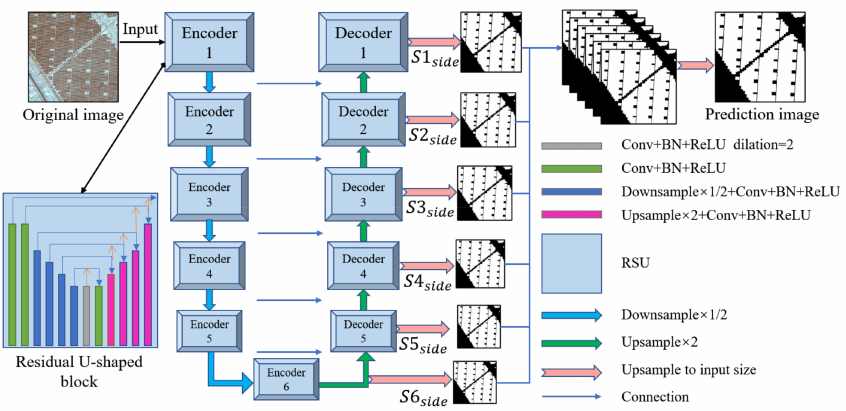
Figure 7. The network structure of U 2